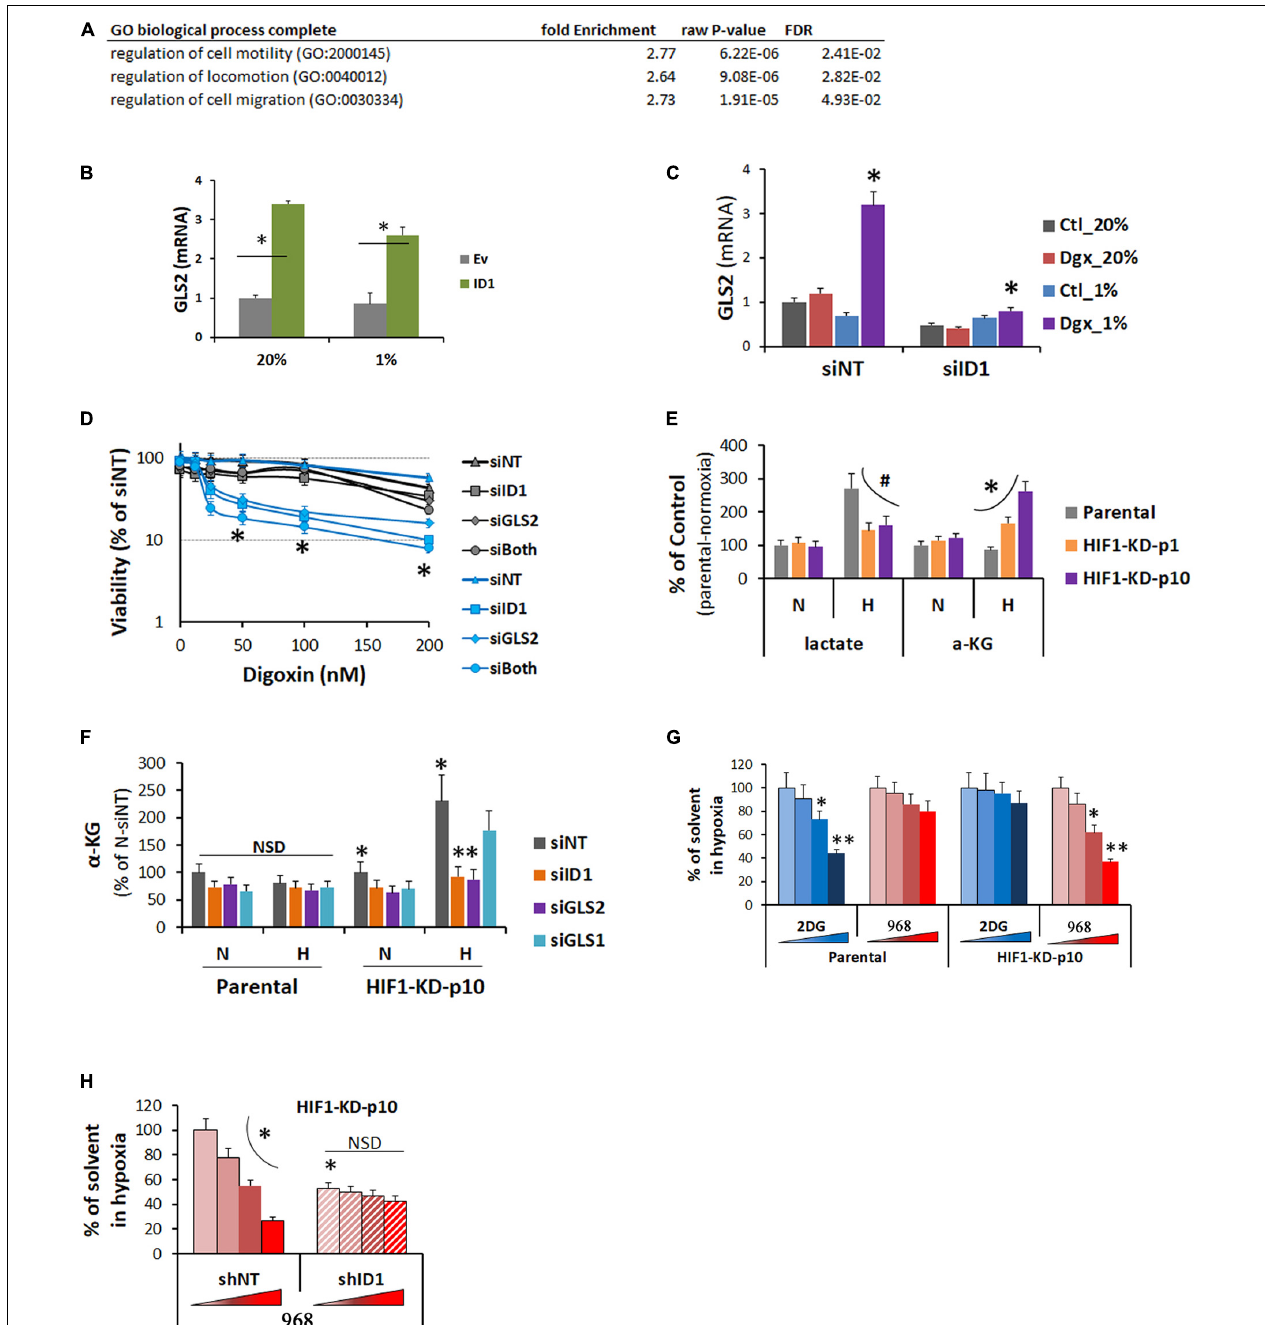
FIGURE 6 | (A) GO pathway analysis of genes upregulated in LNCaP-ID1 vs. LNCaP-Ev cells. (B) LNCaP-ID1/Ev cells were cultured in 20% or 1% O 2 , and GLS2 mRNA were determined by cDNA microarray. ∗ P < 0.05, t -test, mean and stdv, n = 3. (C) Hep3B parental cells were transfected with siRNA (siID1/siNT), and treated by digoxin in 20% or 1% O2 overnight. GLS2 were determined by qRT-PCR. ∗ P < 0.05, t -test, mean and stdv, n = 3. (D) Hep3B-HIF1-KD-p10 cells were transfected with siRNA (siNT, siID1, siGLS2, or siID1++siGLS2), and treated by increasing concentrations of digoxin in 20% or 1% O2 for 72 h. Cell viability were determined by XTT. ∗ P < 0.05, ANOVA, mean and stdv, n = 3. (E) Hep3B-parental, -HIF1 α -KD-P1, or -HIF1 α -KD-P10 cells were cultured in 20% or 1% O 2 for 24 h. Levels of lactate and a-ketoglutarate (aKG) were determined by colorimetric assays from BioVision. #, ∗ P < 0.05, ANOVA, mean and stdv, n = 3. (F) Hep3B-parental/ HIF1 α -KD-P10 cells were transfected with siRNA (siNT, siID1, siGLS1, or siGLS2), and cultured in 20% or 1% O2 overnight. Then, α KG was determined by colorimetric assays from BioVision. ∗ , ∗∗ P < 0.05, t -test, mean and stdv, n = 3. (G) Hep3B-parental/HIF1 α -KD-P10 cells were treated with increasing doses of glycolysis inhibitor 2DG or GLS2 inhibitor 968 (Sigma) in 1% O 2 . Cell viability was determined by XTT. ∗ , ∗∗ P < 0.05, t -test, mean and stdv, n = 3. (H) HIF1 α -KD-p10 cells were transfected with shNT or shID1, and treated by GLS2 inhibitor 968 in 1% O 2 as in (G) . Cell viability was determined by XTT, ∗ P < 0.05, t -test, mean and stdv, n =